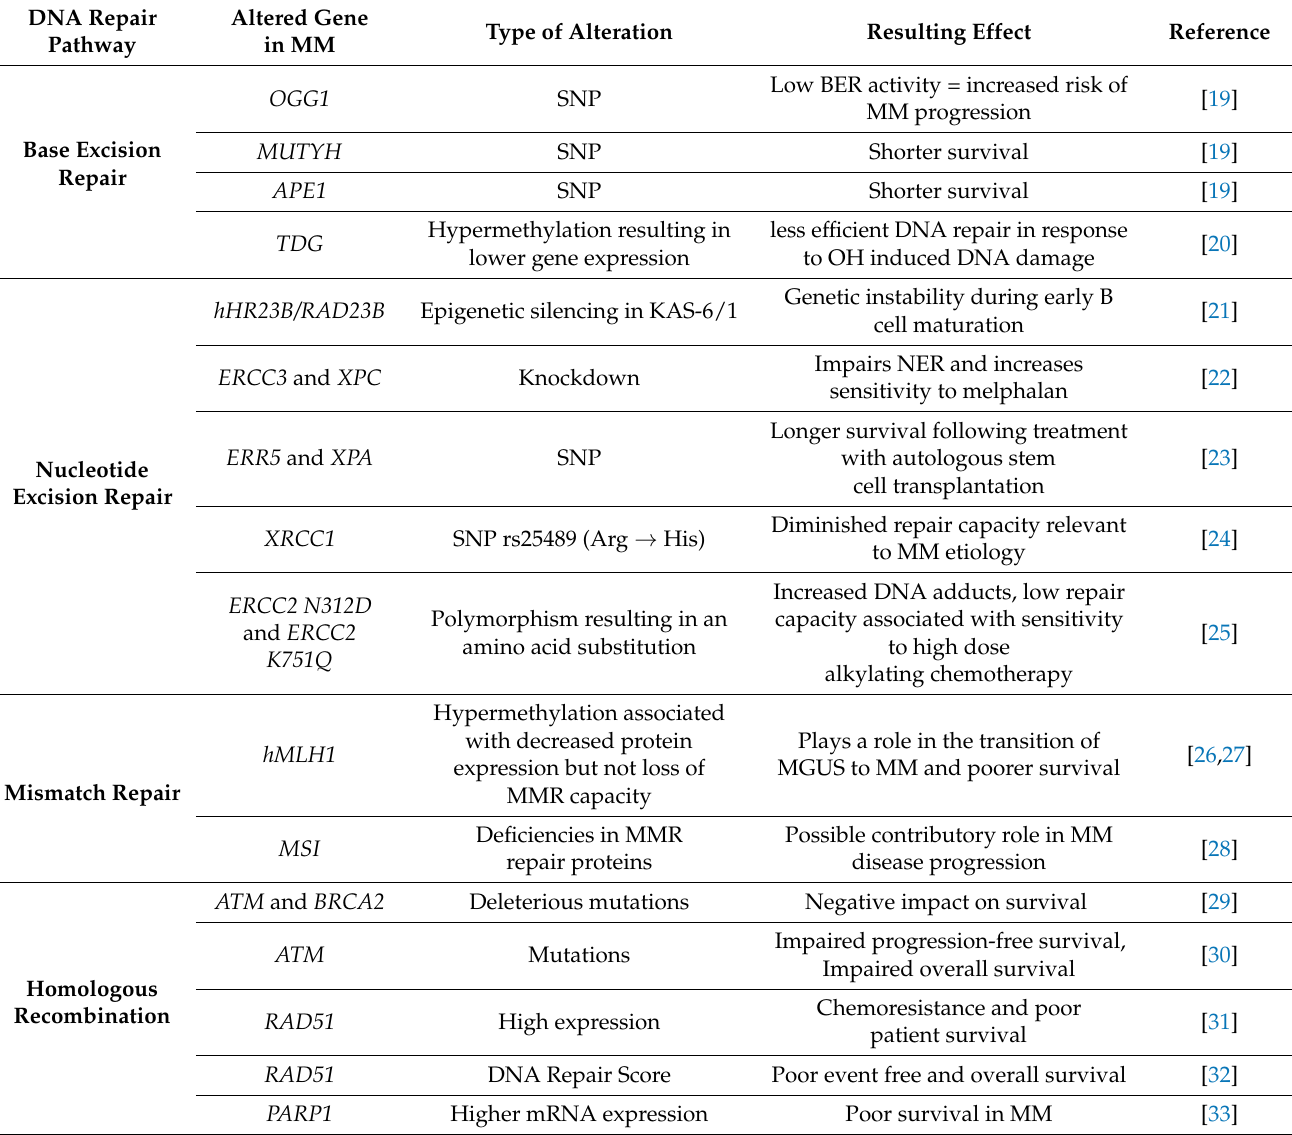
Table 1. Altered DNA Repair Pathway genes and their effect on